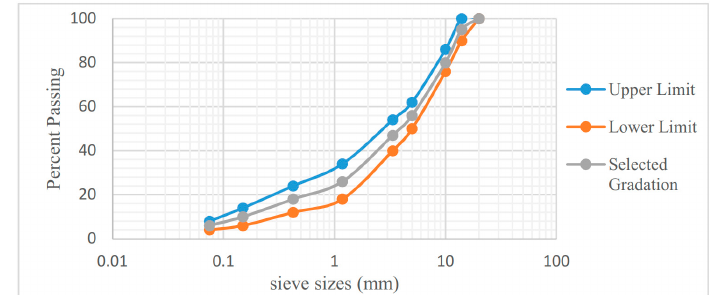
Figure 1. Gradation plot with JKR -sp ecified limits.